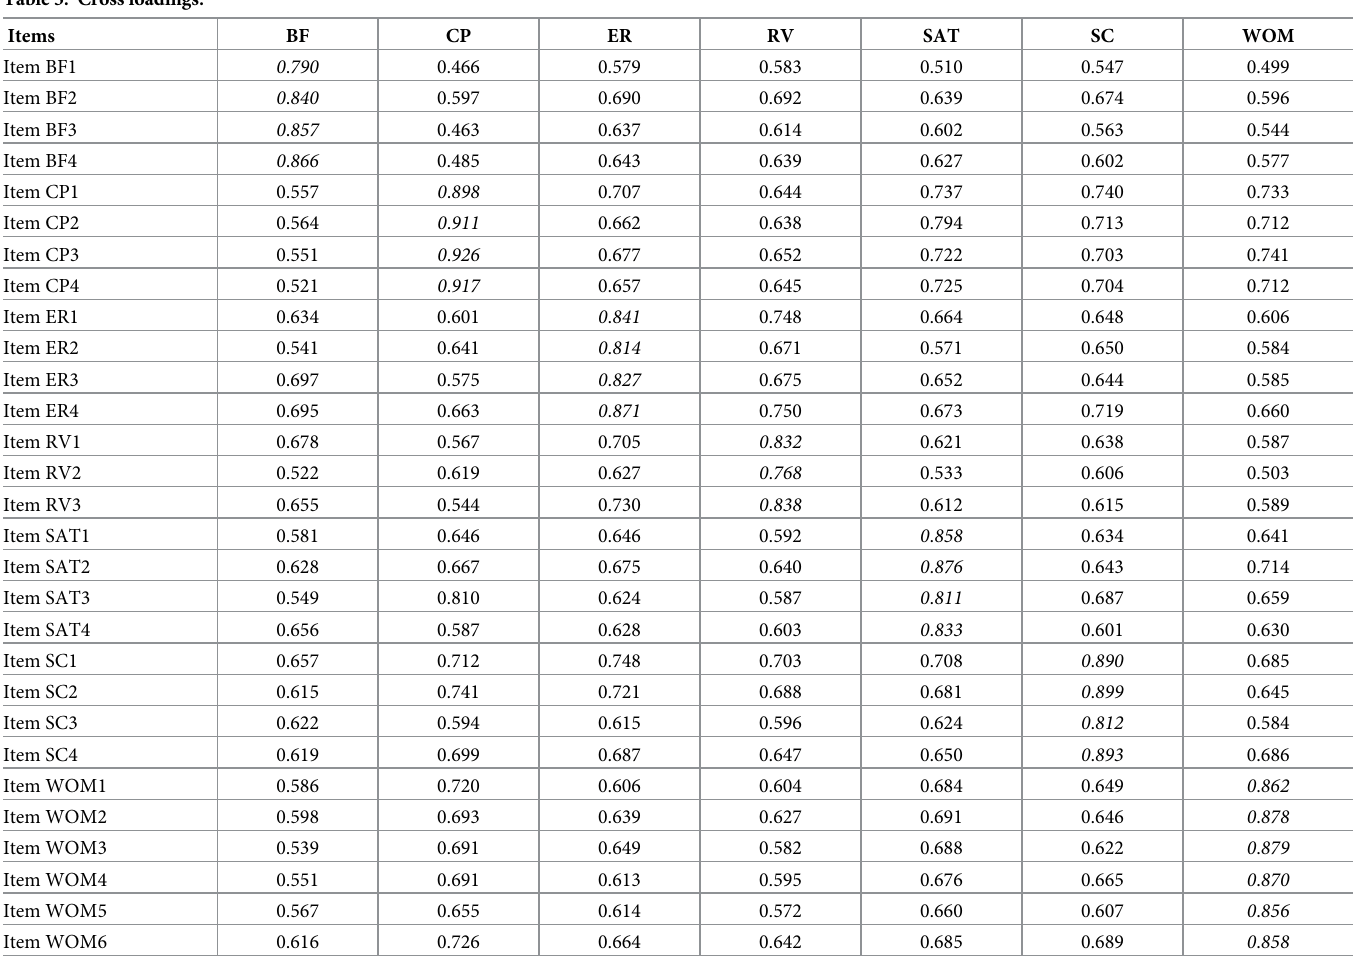
Table 5. Cross loadings.